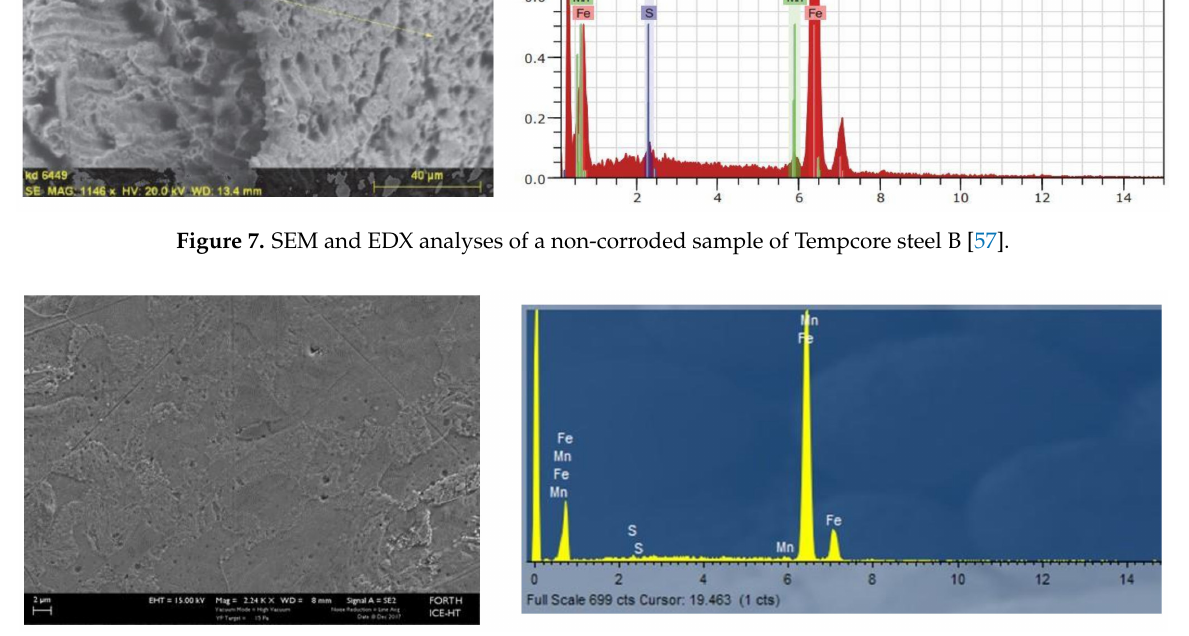
Figure 8. SEM and EDX analyses of non-corroded sample of Dual Phase steel